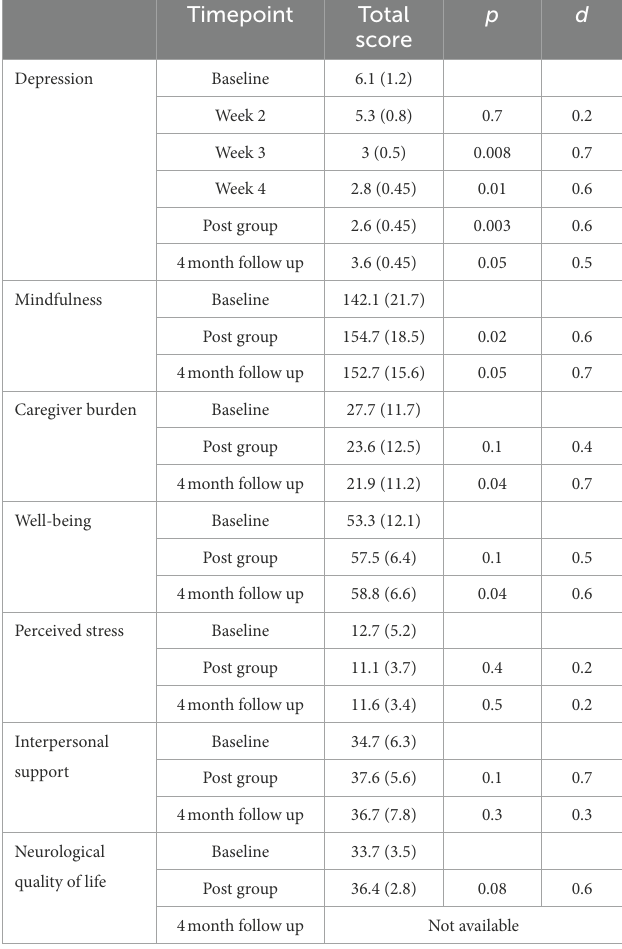
TABLE 2 Clinical